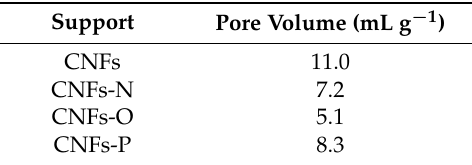
Table 3. Specific support pore